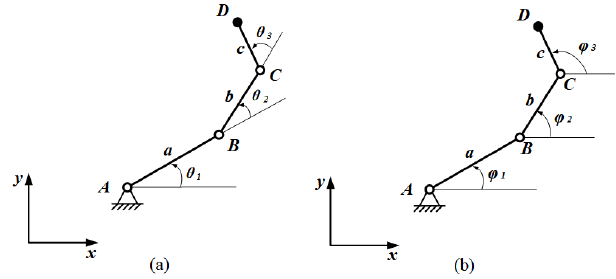
Figure 4. Planar 3R serial chain and its kinematic skeleton.